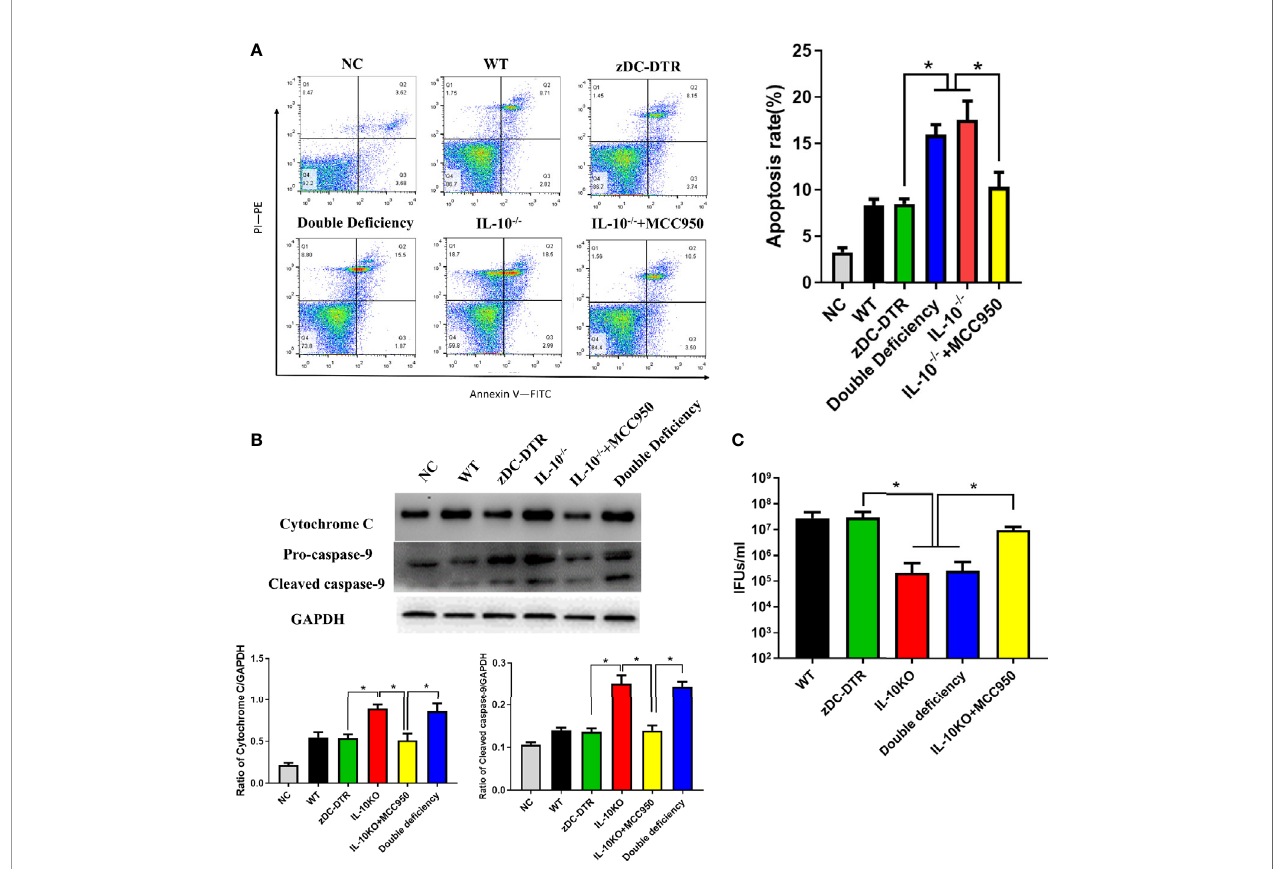
FIGURE 8 | Activation of DC apoptosis was upregulated in IL-10 − / − DCs via NLRP3 in fl ammasome pathway. (A) Flow cytometry detection of Annexin-V-FITC- and PI-PE-positive BMDCs with an MOI of C. psittaci at 72 hpi. The four quadrants were gated by negative control. Signi fi cant higher apoptosis was observed in the IL-10 − / − and the DD groups compared to the WT and the zDC-DTR groups. Treatment with the NLRP3-speci fi c inhibitor MCC950 lowered apoptosis compared with that of the DD and IL-10 − / − groups. (B) The levels of cytochrome C and pro-caspase 9 were determined by Western blotting. Both cytochrome C and pro-caspase 9 were signi fi cantly upregulated in the IL-10 − / − and the DD groups compared with the zDC-DTR group. (C) Lysis of cells via ultra-sonication. Infectious progeny EBs were counted using IFU assay. All data were expressed as the mean ± SD (n=5 per group). The differences were analyzed by ANOVA (* P